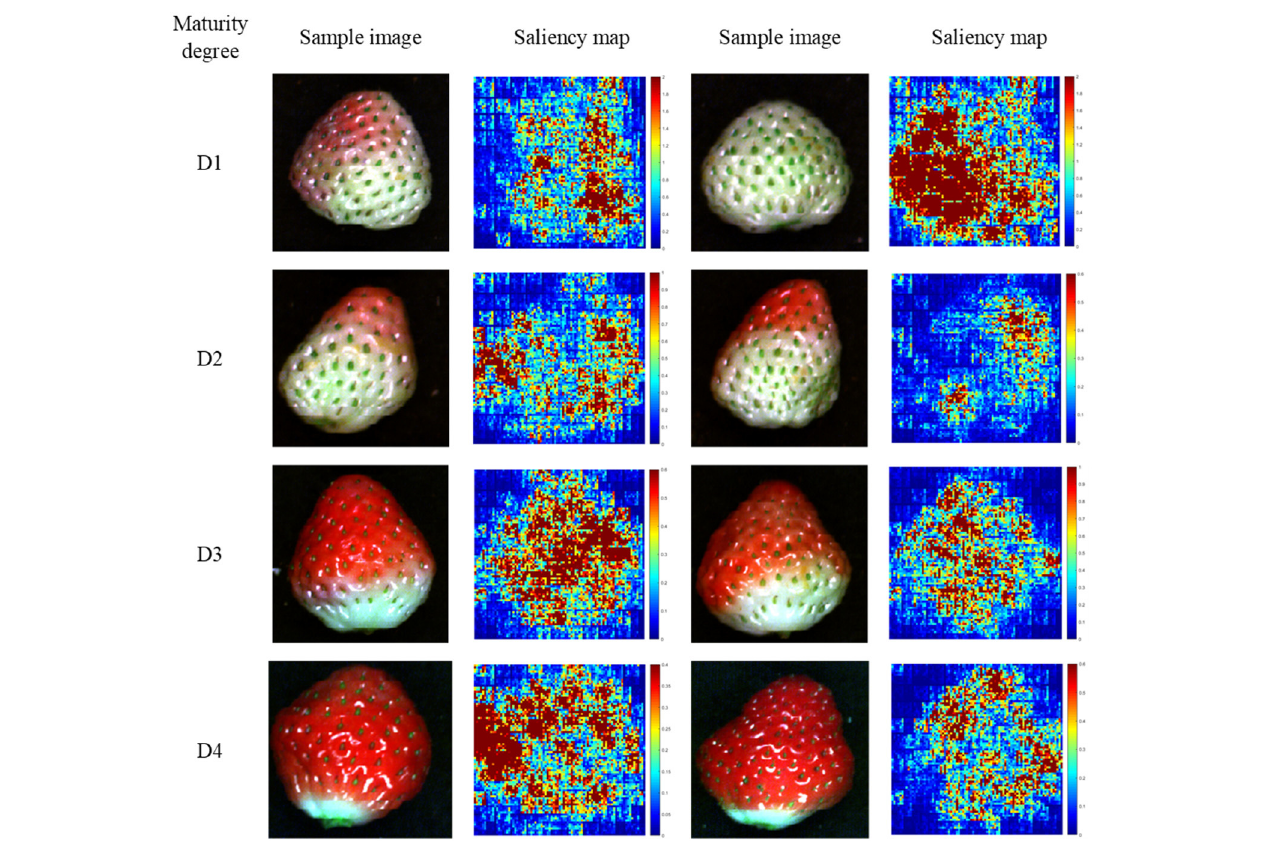
FIGURE 7 | The saliency maps of two randomly selected hyperspectral images of the testing sets of each maturity degree based on 3D ResNet. Colors in the colorbar indicated the corresponding contribution values of each pixel in the hyperspectral images. The colors in the colorbar from the bottom to the top represented the values from low to